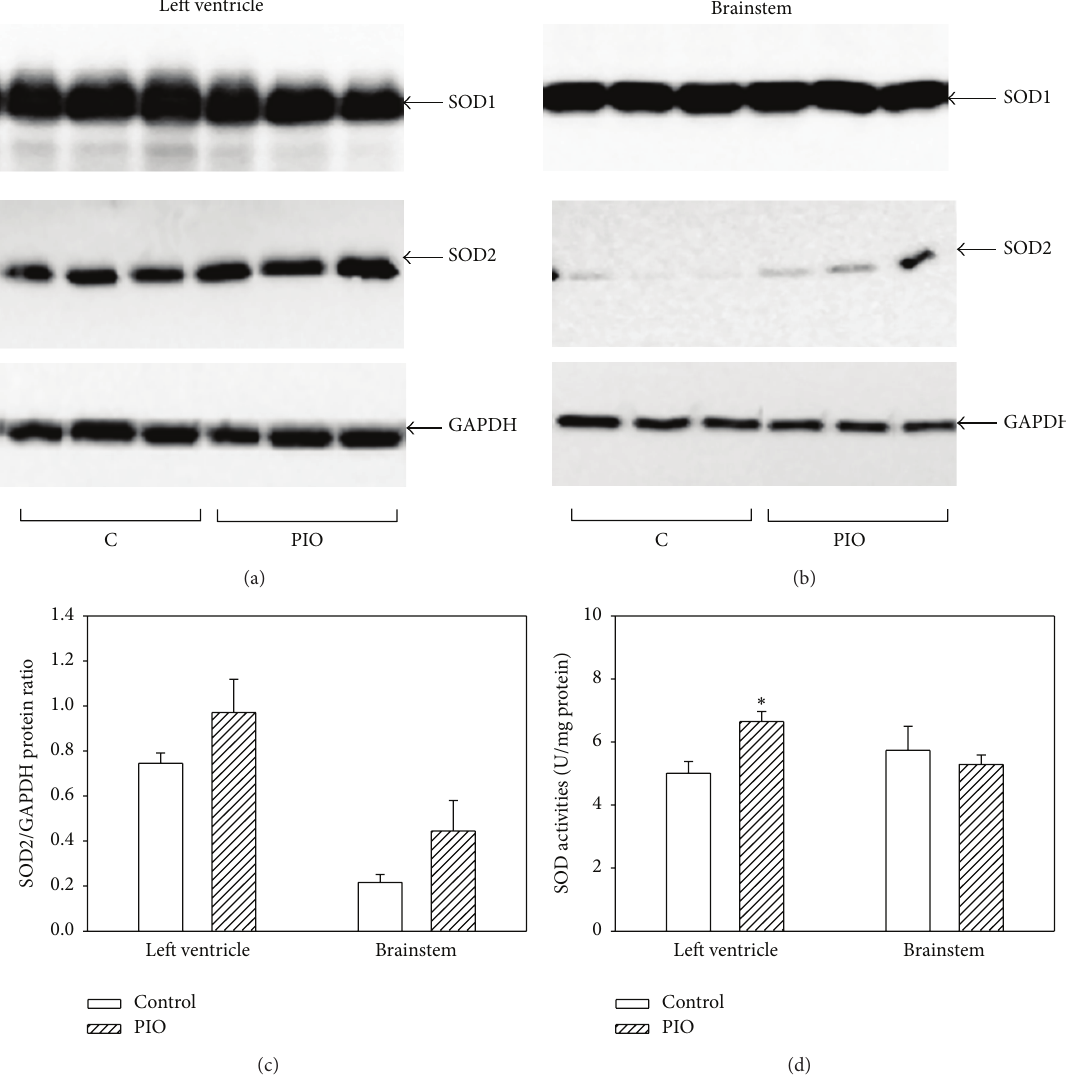
Figure 5: Effect of pioglitazone administration on SOD1 and SOD2 protein levels and total SOD activities in the left ventricle and brainstem of young SHRs. (a) Western blot records documenting SOD1, SOD2, and GAPDH protein levels in fraction isolated from the tissues of the left ventricle of control and PIO-treated group. (b) Western blot records documenting SOD1, SOD2, and GAPDH protein levels in brainstem. (c) Quantification of SOD2 protein levels normalized to the GAPDH protein levels. Data were obtained from Western blot records and each bar represents mean ± SEM of 7 tissue samples per group. ∗ 𝑃 < 0.05 , PIO versus control. (d) The SOD activities were analyzed using the SOD Assay kit (Fluka) in tissue samples of left ventricle and brainstem. The specific activities are expressed in units per mg of proteins and are presented as mean ± SEM, 𝑛 = 7 . ∗ 𝑃 < 0.05 , PIO versus